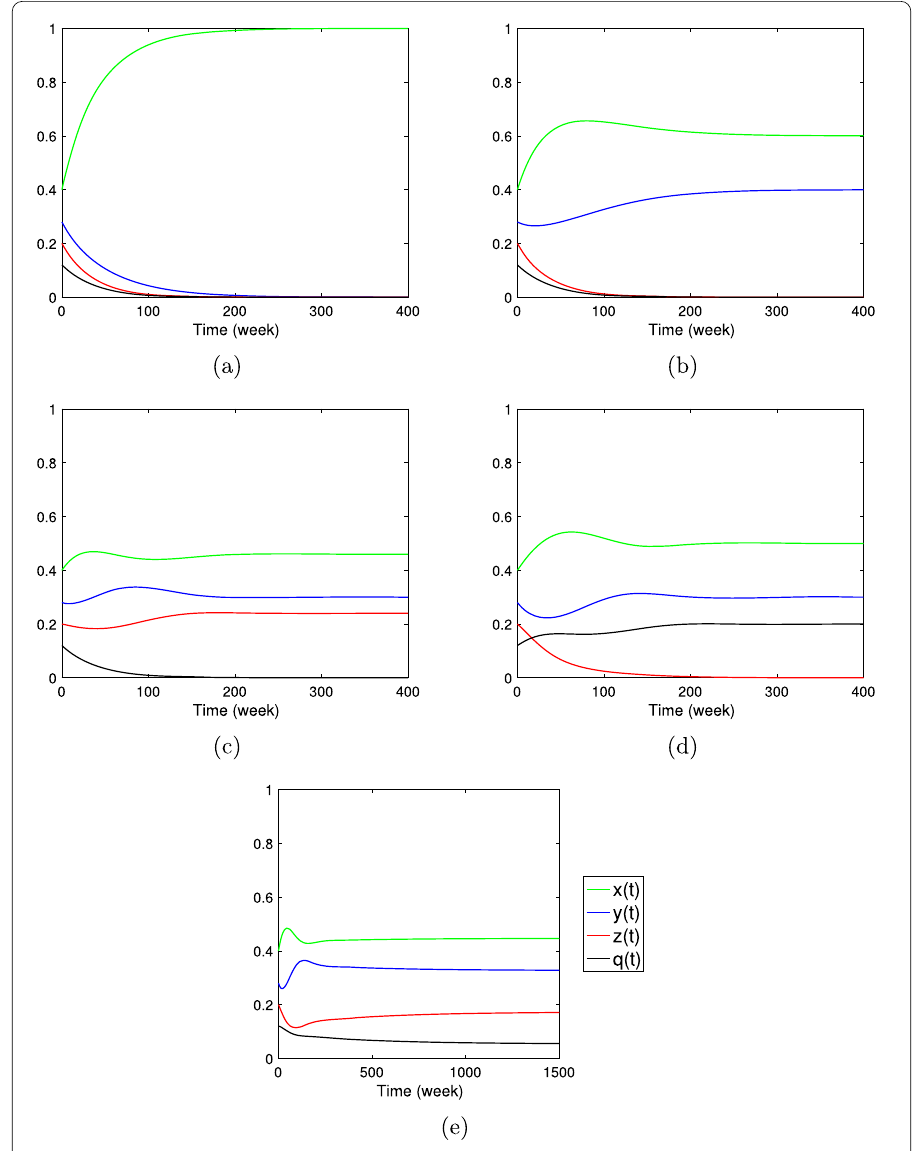
Figure 6 The dynamical behavior of system (4) with different sets of parameters. ( a ) Free equilibrium E 2,0 , ( b ) Overweight equilibrium E 2,1 , ( c ) Free quitter equilibrium E 2,2 , ( d ) Free obese equilibrium E 2,3 , ( e ) Positive equilibrium E